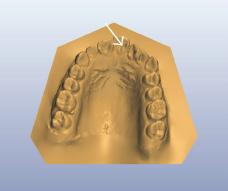
Figure 4: Preoperative 3D model: occlusal view showing mild anterior crowding with maxillary anterior teeth and Bolton’s dis-